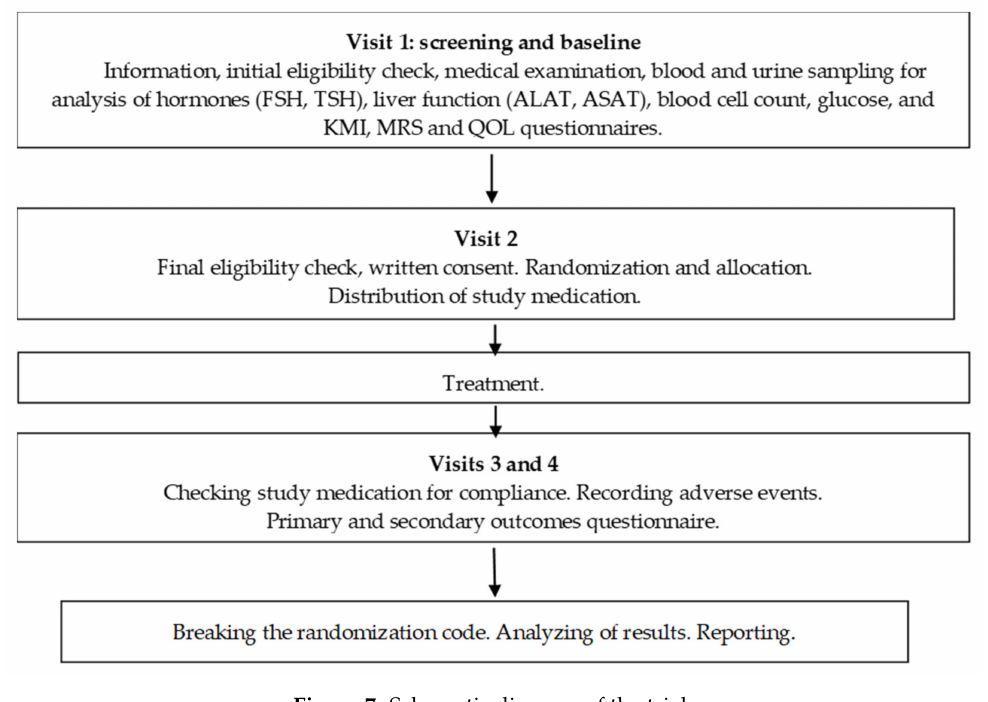
Figure 7. Schematic diagram of the trial. Table 5. Schedule of examinations and